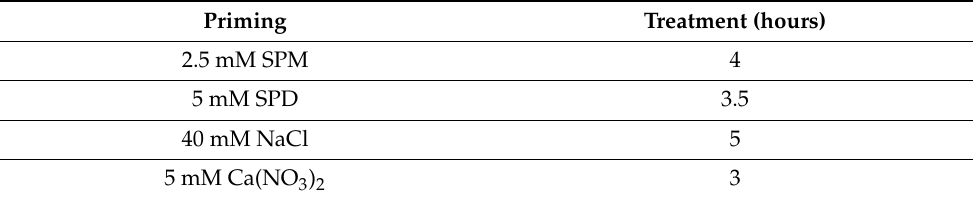
Table 7. Chemical priming treatments of the seeds with the different priming solutions.At the end of the treatments, the seeds were dried at room